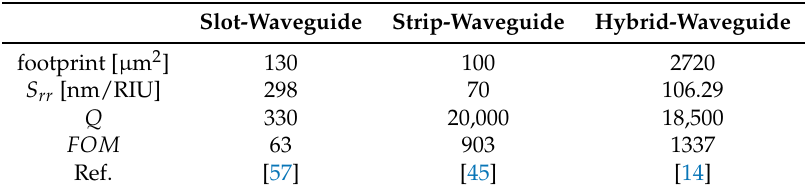
Table 1. Comparison of different ring resonators based on SOI-technology. ( c (cid:13) 2018 IEEE. Reprinted, with permission, from Ref.